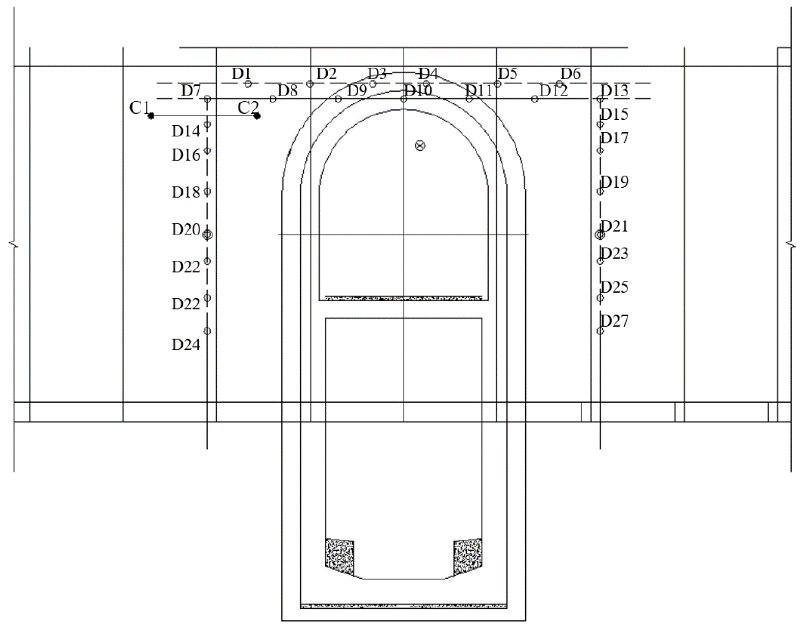
Figure 2. Layout of freezing holes on the machine room side.